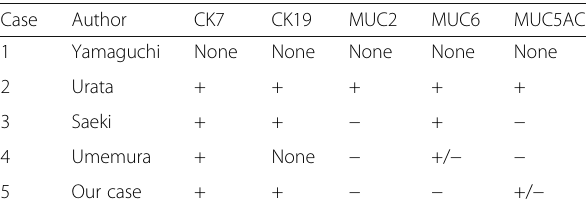
Table 2 Immunohistochemical staining of primary ITPN in five cases that recurred in the remnant